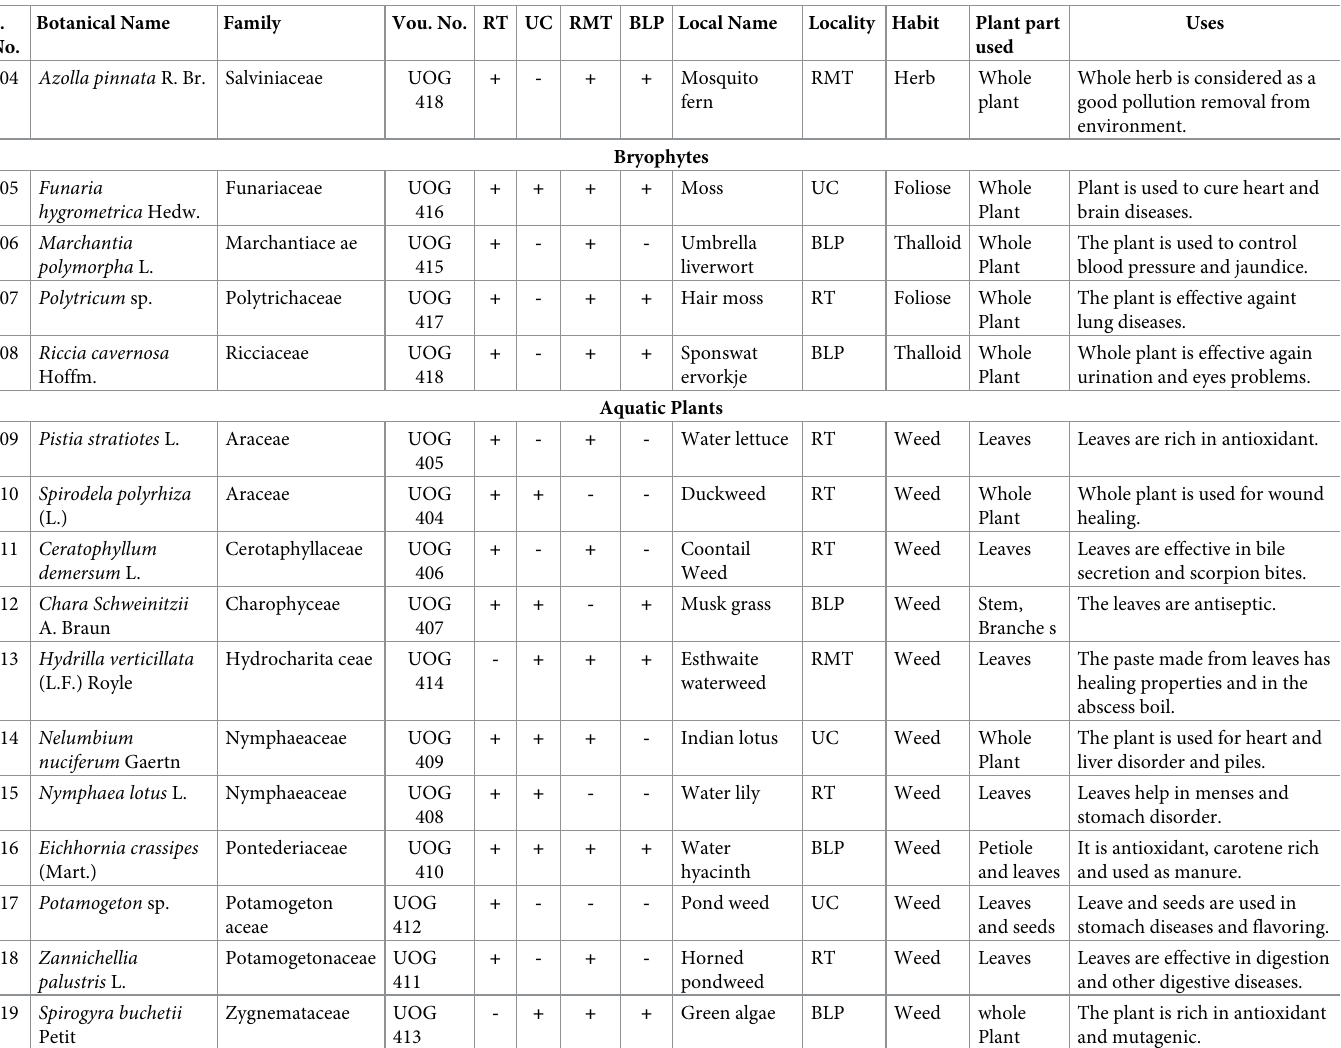
Green algae BLP Weed whole